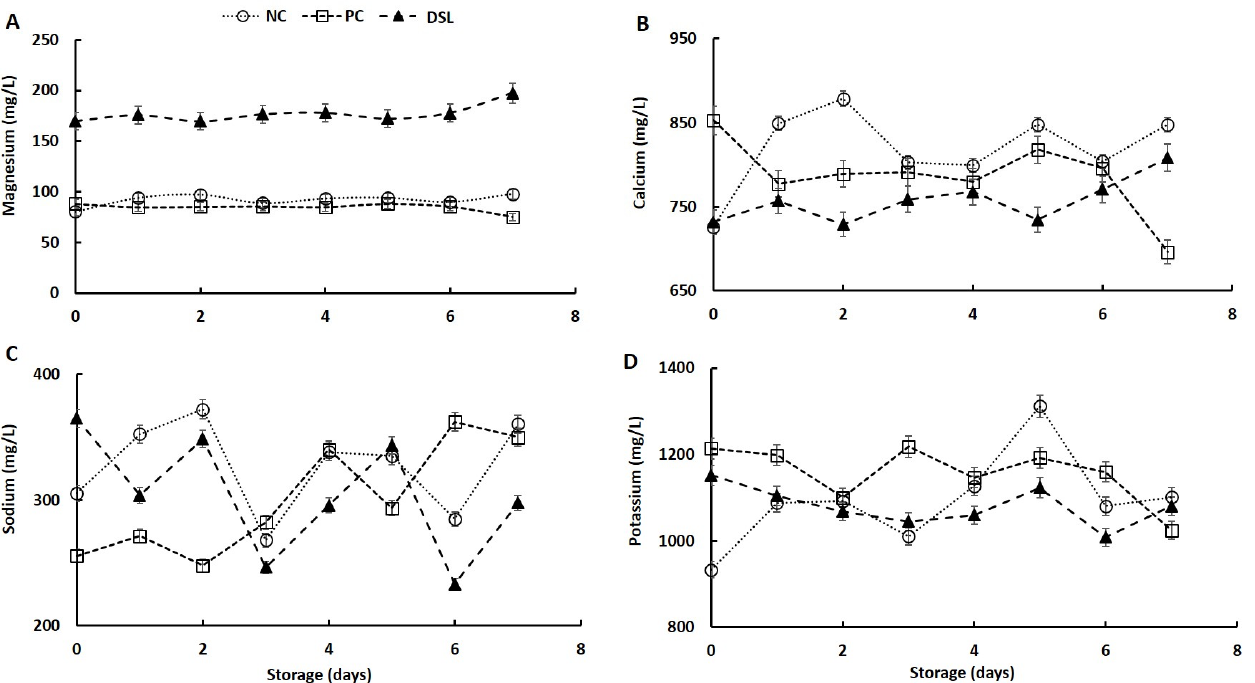
Figure 3. Changes in magnesium ( A ), calcium ( B ), sodium ( C ), and potassium ( D ) content of date syrup-fortified laban (DSL), positive control (PC), and negative control (NC) drinks during cold storage at 4 °C for 7 days.